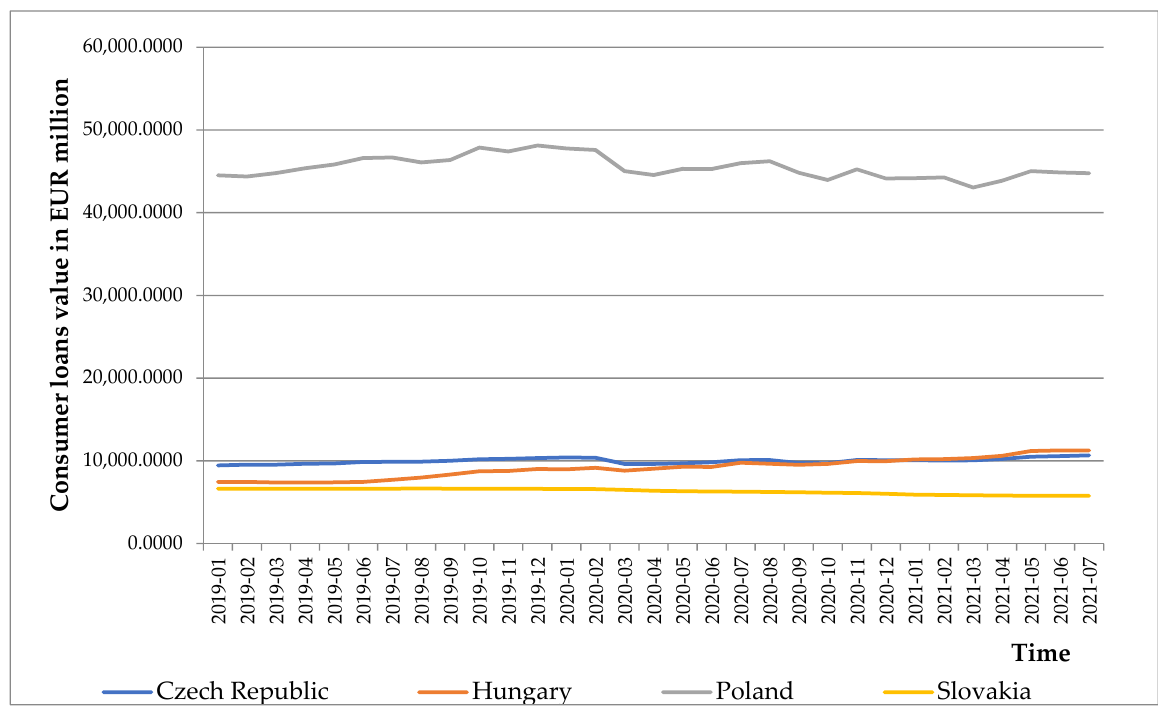
Figure 1. Value of consumer credit in the V4 countries in the period from January 2019 to July 2021 (in EUR million). Source: (https://sdw.ecb.europa.eu/browse.do?node=9691311 (accessed on 25 September 2021).